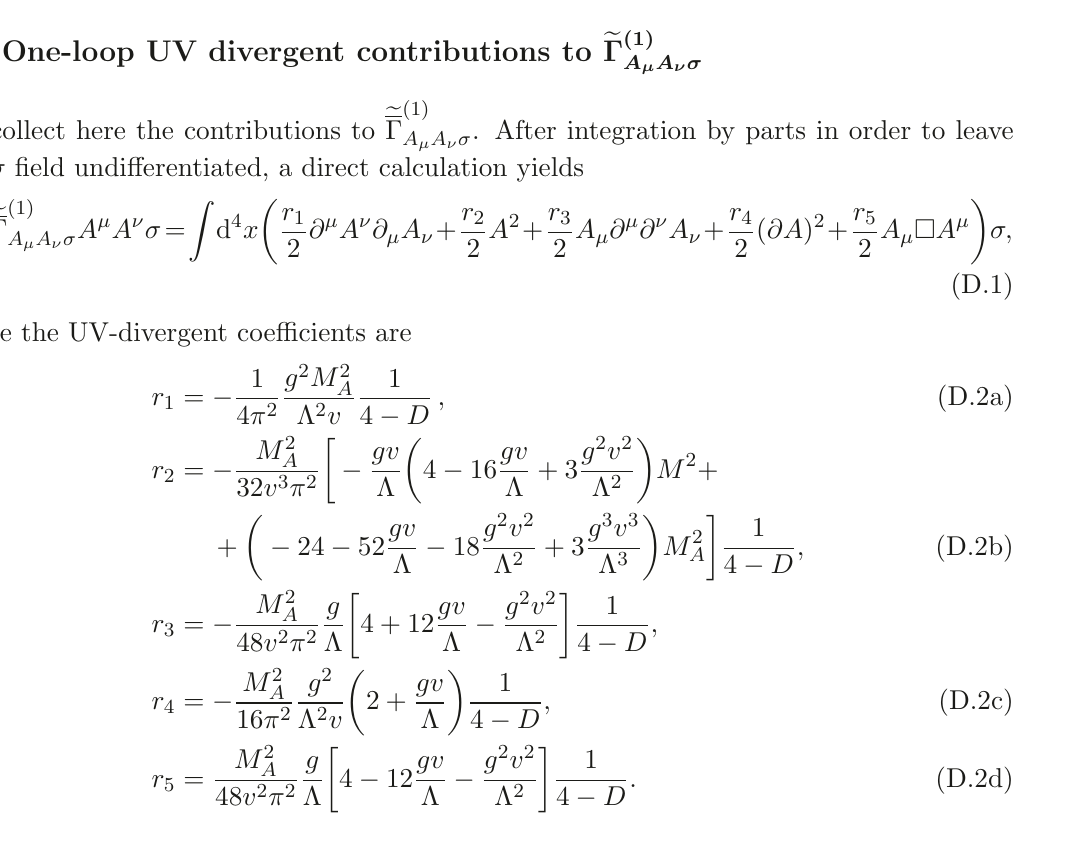
Figure 4 . Contributions to W ¯ c ∗ ¯ c ∗ at one loop. Vertices indicate the insertion of ¯ c ∗ , whereas straight lines denote the X 1 and/or σ ′